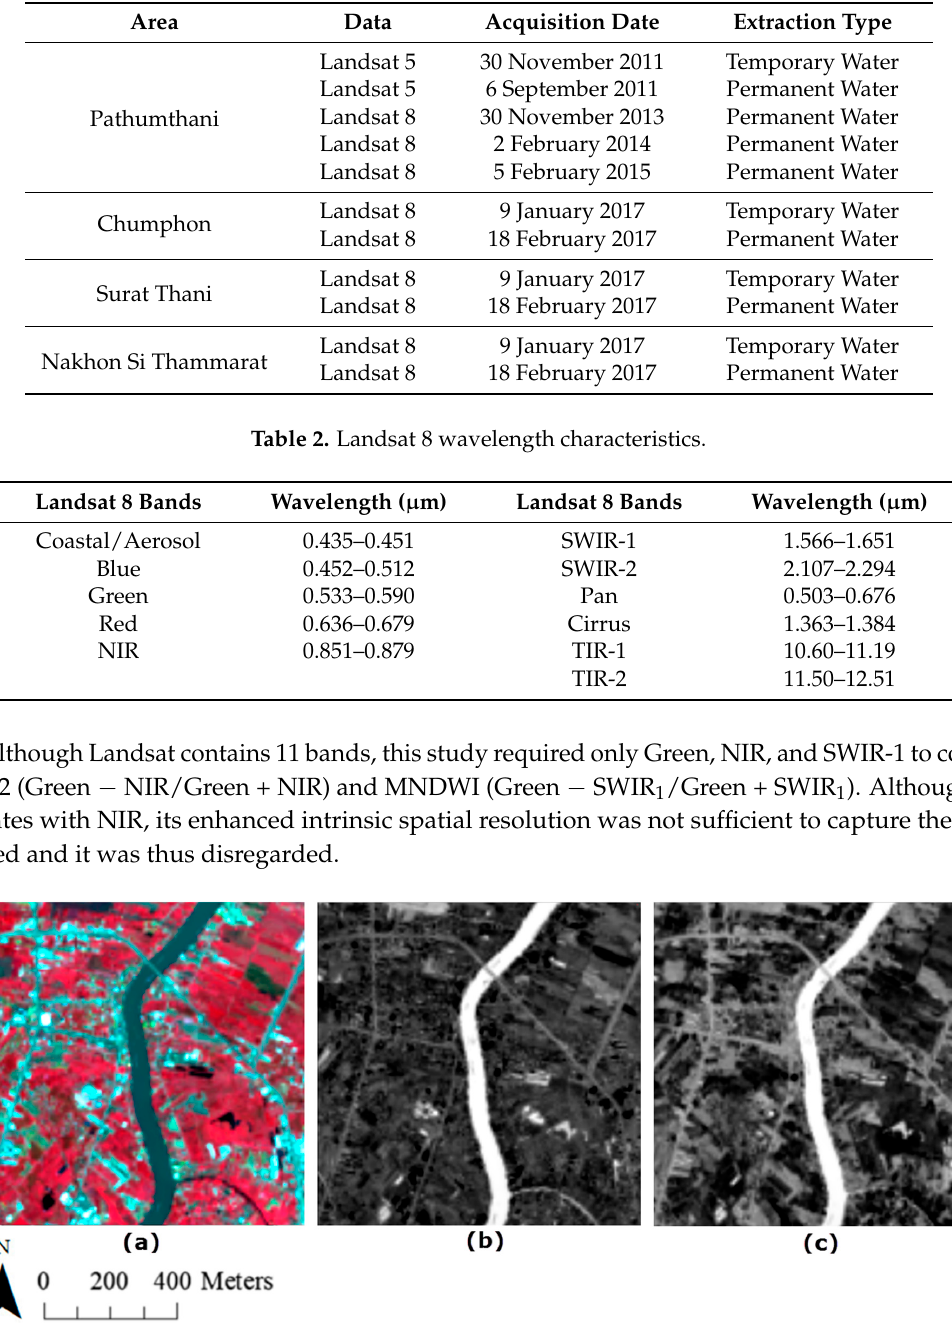
Table 1. Detailed description of the Landsat images acquired in four cities in Thailand.